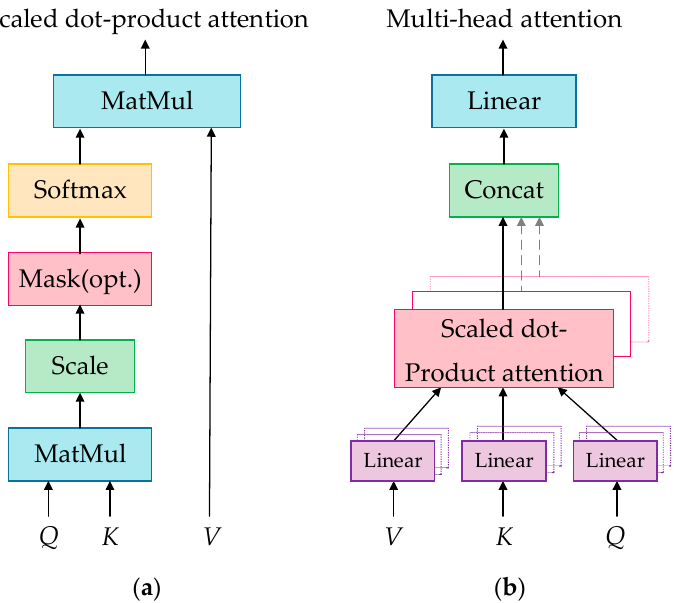
Figure 3. Two a tt ention models: ( a ) scaled dot-product a tt ention model; ( b ) multi-head a tt ention